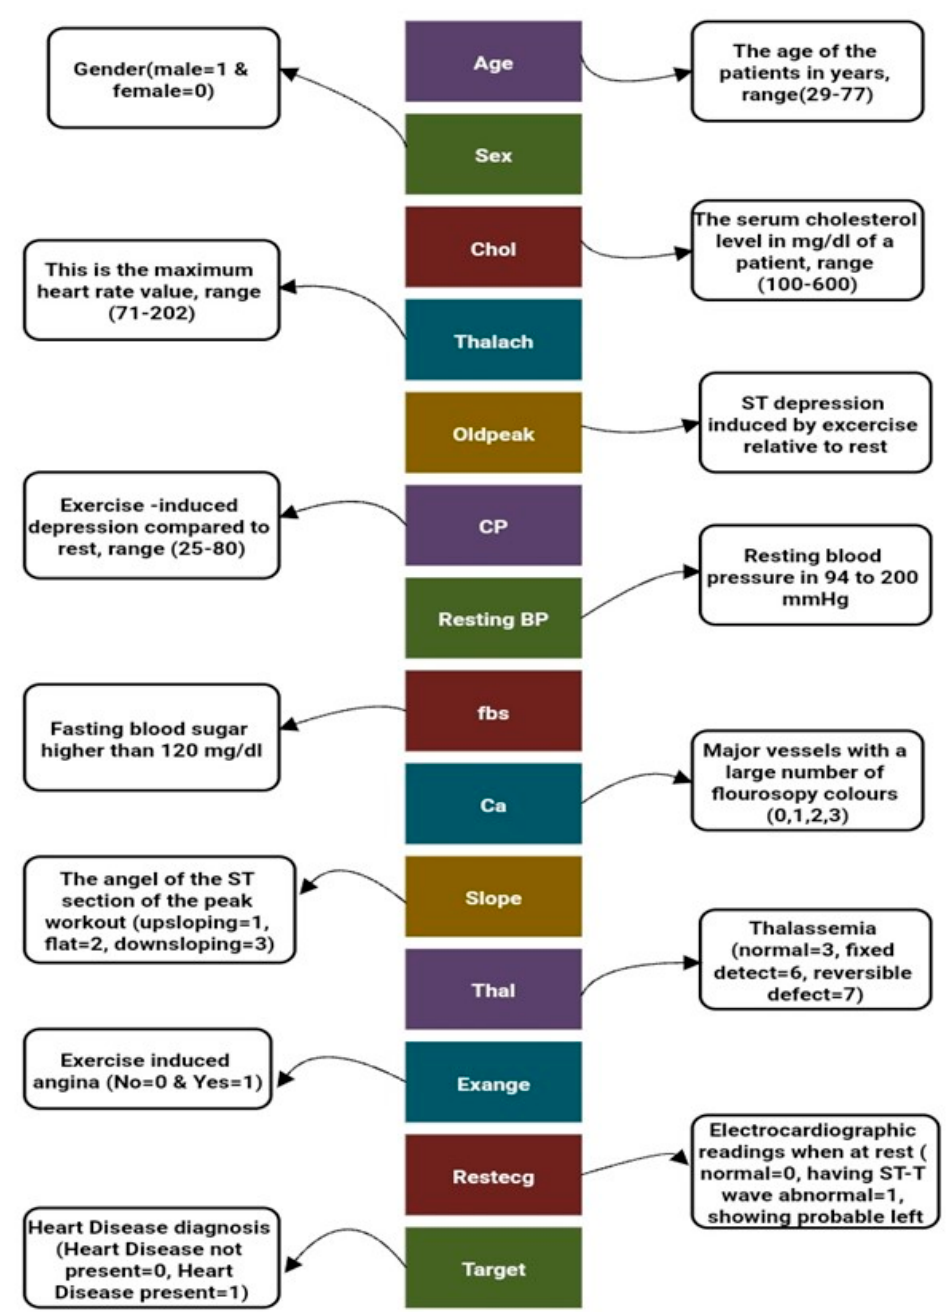
Figure 2. Heart disease prediction parameters.